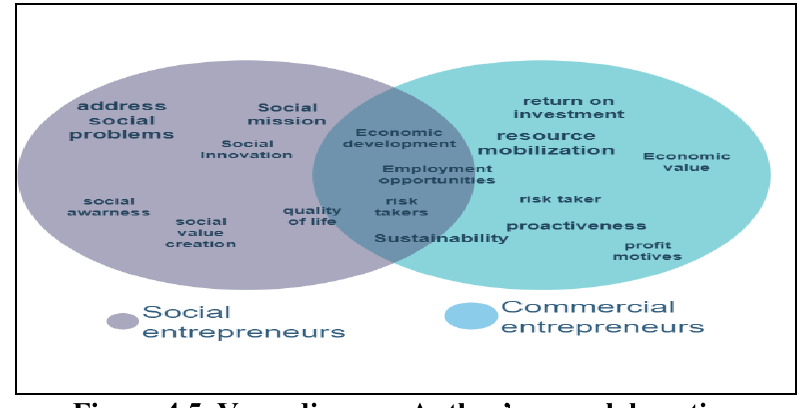
Figure 4.5. Venn diagram Author’s own